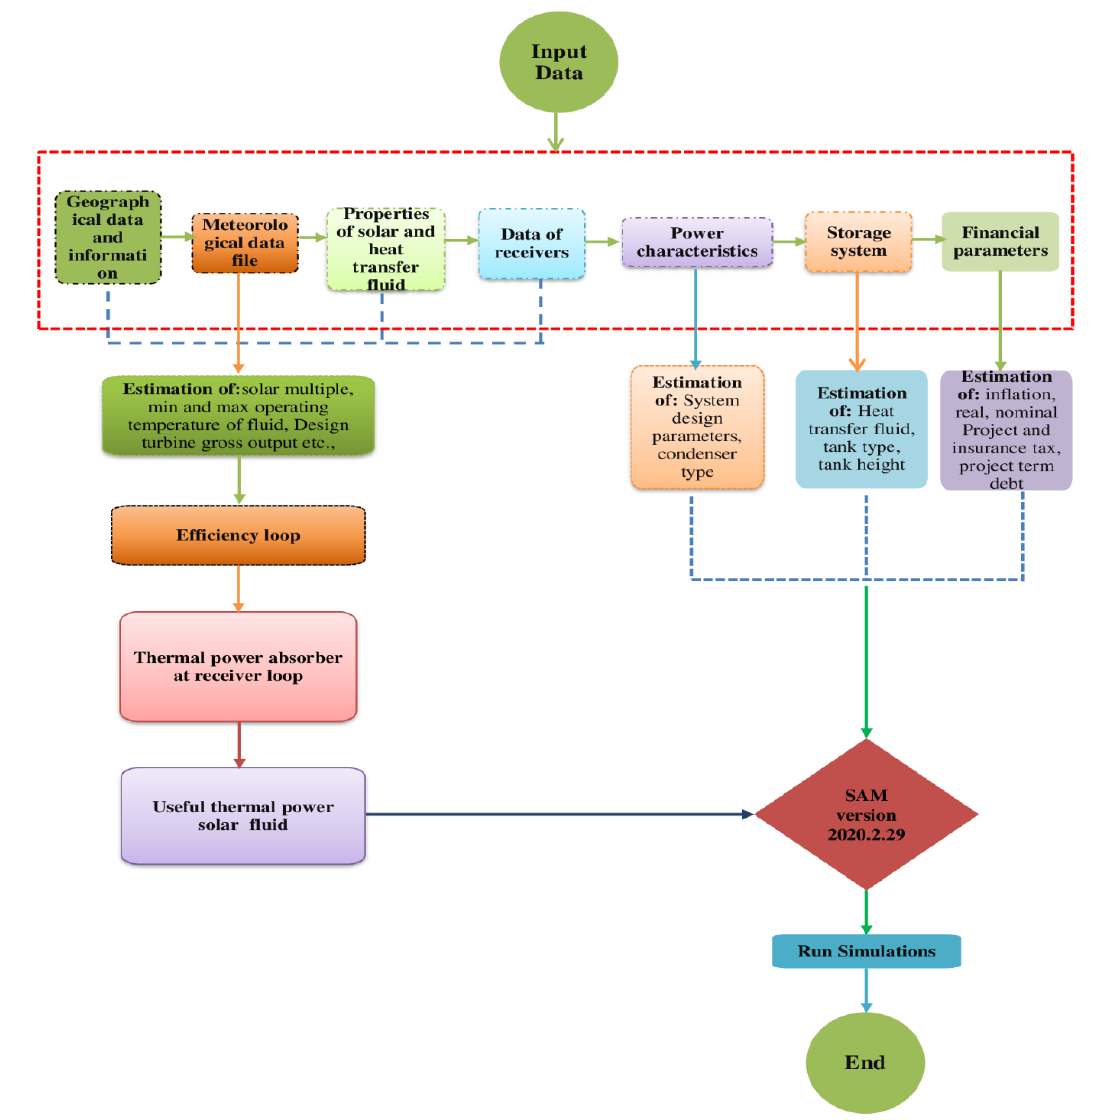
Figure 1. Flow diagram of the simulation process in the SAM software (modified from [31] with permission from Elsevier) .